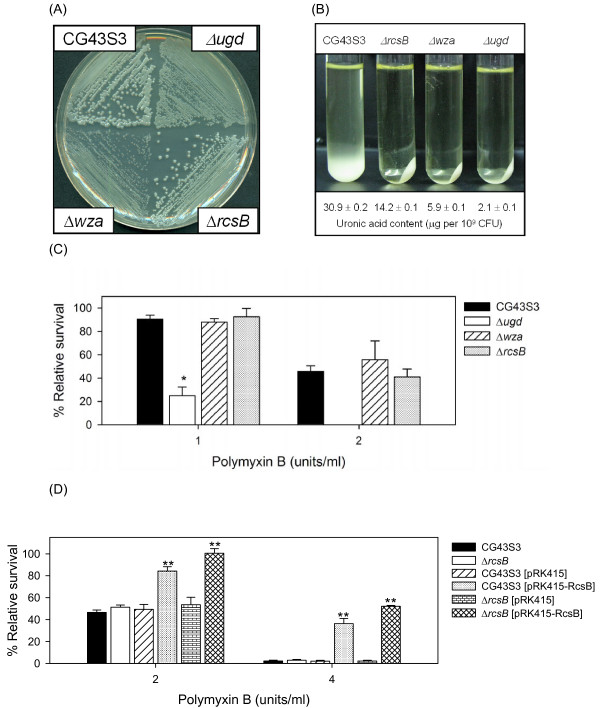
Deletion effects of ugd, wza and rcsB genes on Klebsiella CPS production and resistance to polymyxin B. (A) Comparison of colony morphology. The K. pneumoniae strains were streaked on an LB agar plate, incubated at 37°C overnight and photographed. (B) Sedimentation test. The strains were cultured overnight in LB broth at 37°C and subjected to centrifugation at 4,000 ×g for 5 min. Quantification of K2 CPS amounts of each strain is shown below the figure. Values are shown as averages ± standard deviations from triplicate samples. (C) Polymyxin resistance assay. The log-phased cultures of K. pneumoniae CG43S3, Δugd, Δwza or ΔrcsB mutants were challenged with 1 or 2 units/ml of polymyxin B. (D) Polymyxin resistance assay. The log-phased culture of K. pneumoniae strains were challenged with 2 or 4 units/ml of polymyxin B. The survival rates are shown as the average ± standard deviations from triplicate samples. *, P < 0.01 compared to the parental strain CG43S3. **, P < 0.01 compared to each strain carrying pRK415.